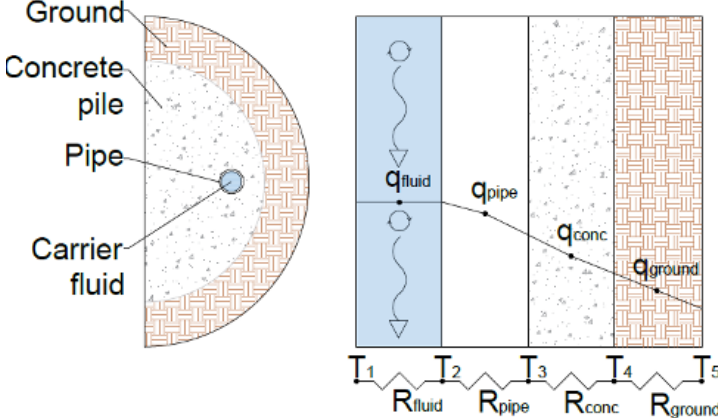
Figure 1. Description of mechanism of heat transfer from primary circuit of energy pile to